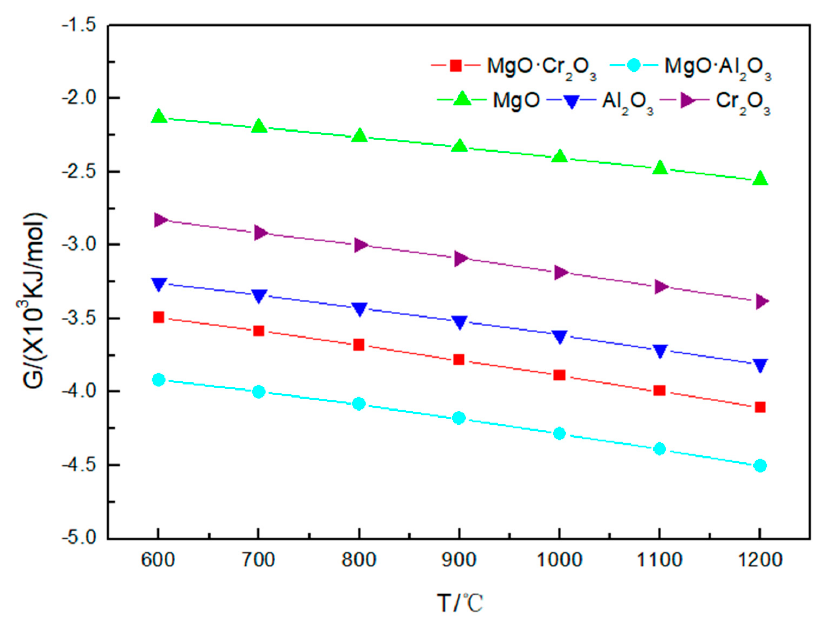
Figure 2. Gibbs free energy of the five corrosion reactions between Na 2 CO 3 and refractory materials at 600–1200 °C.